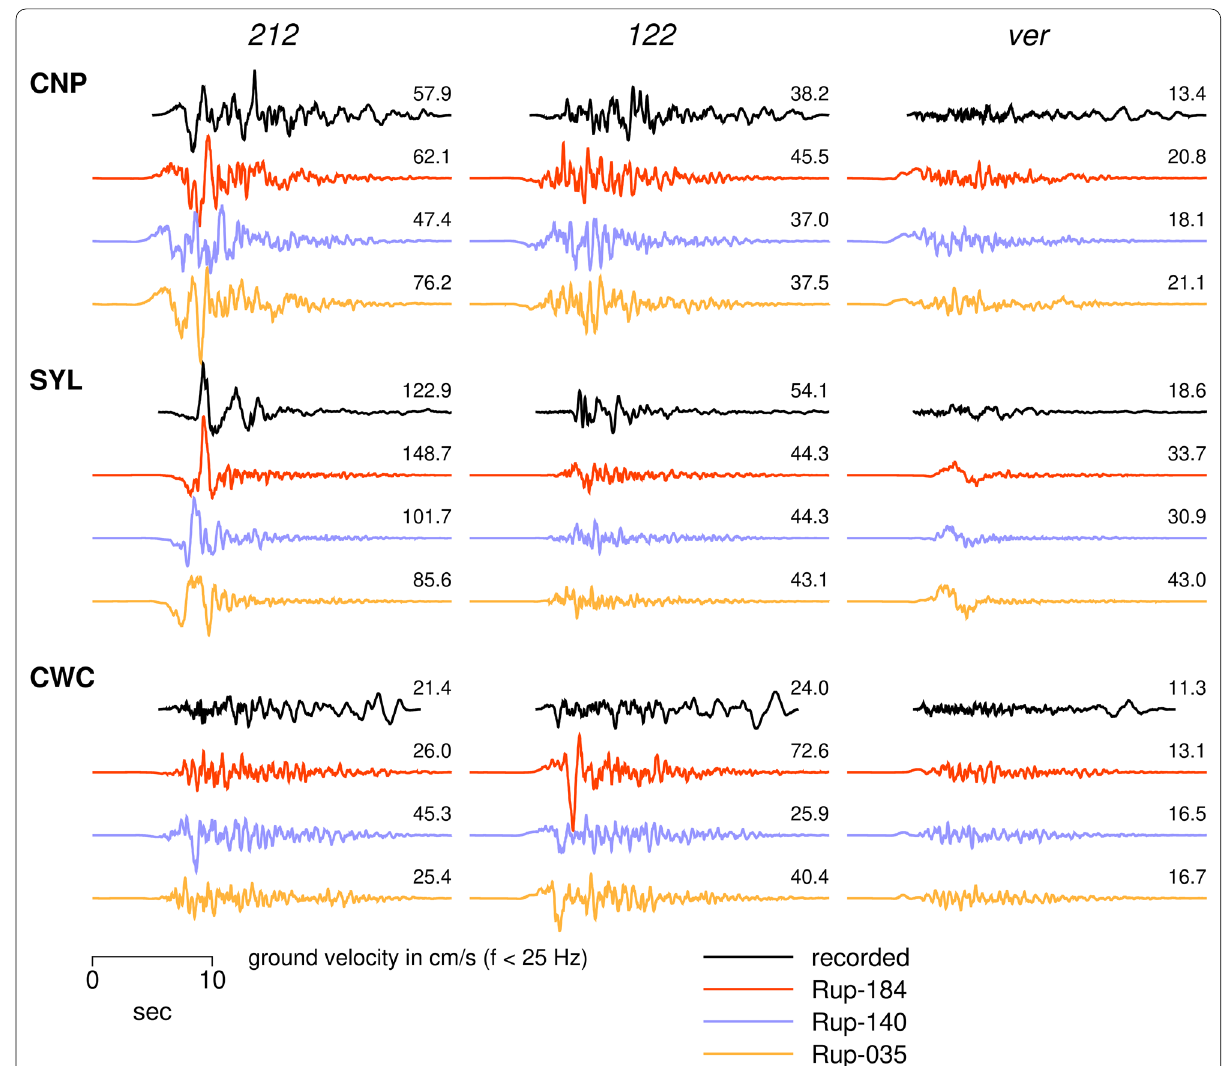
Fig. 9 Three-component, broadband ground velocities for the three lowest | M | avg simulations compared with observed motions at stations CNP, SYL, and CWC. The horizontal components have been rotated to fault-normal (212°) and fault-parallel (122°) orientations. Absolute timing is not available for the observations so records have been shifted to roughly align with first arriving P-wave in the simulations. Peak amplitude shown at top right of each